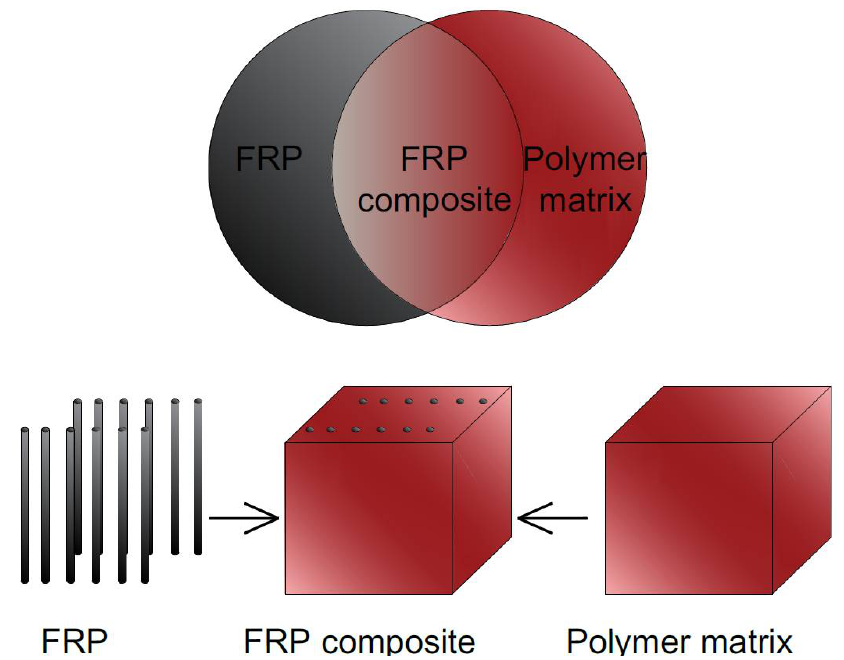
Figure 2 . The idea of FRP composites, adapted from [ 17 ].